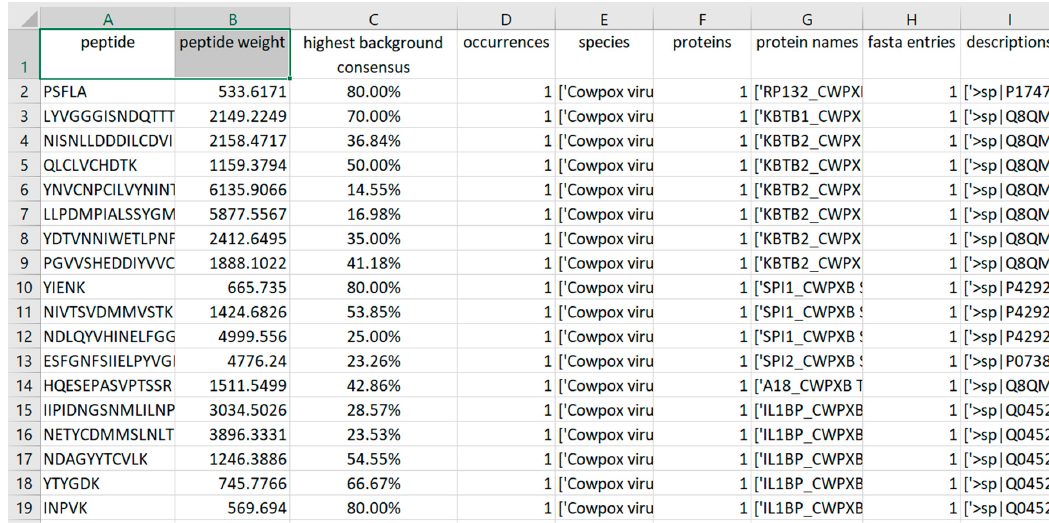
Figure 3. Graphical representation of the Purple output. The tabular TSV output of Purple can be imported into various spreadsheet software tools. This exemplary table shows the peptide sequence, the calculated theoretical mass weight (Da), the highest background consensus, and the number of peptide occurrences in the target proteome. The species, protein name and full description of the associated protein are stored in a list for further analysis. In addition, the number of proteins and FASTA entries are listed separately, because they can diverge, e.g., when a protein has multiple sequence variants.